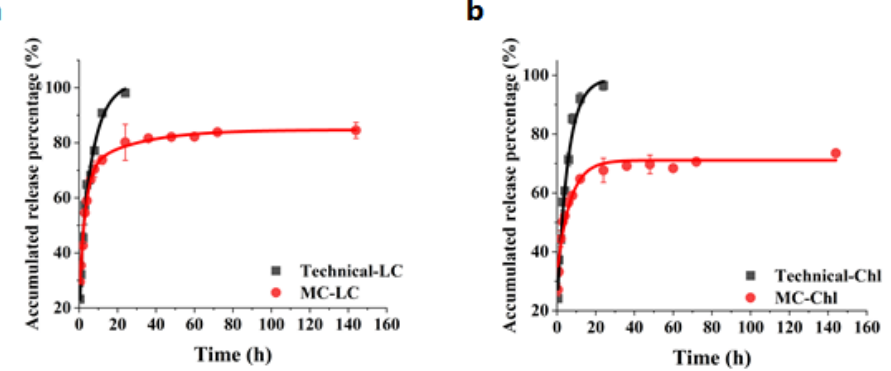
Figure 6. Cumulative release curves of technical and nano microcapsules. ( a ) Lambda Cyhalothrin (LC) and ( b ) Chlorantraniliprole (Chl).